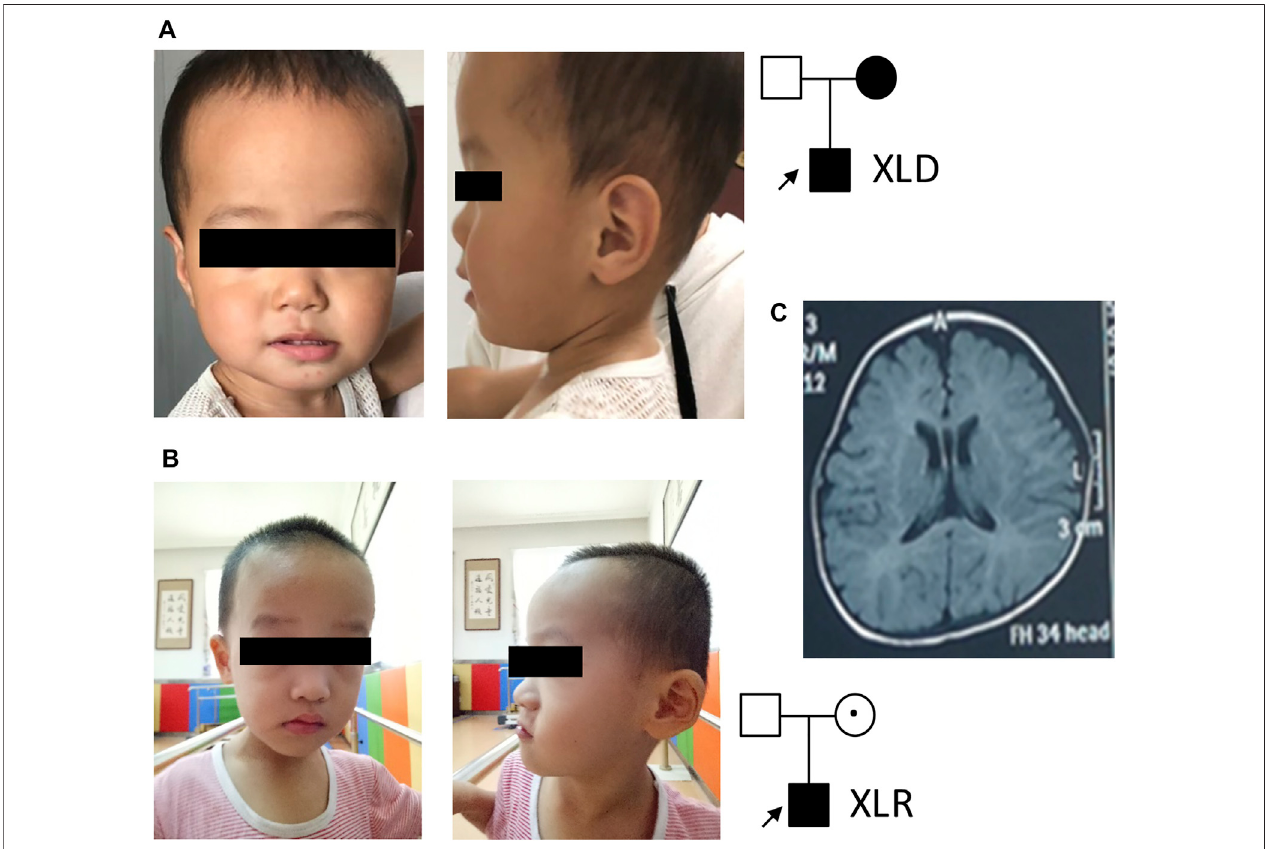
FIGURE 1 | Patient pedigrees and radiographic fi ndings. (A) Patient 1 photo and pedigree. (B) Patient 2 photo and pedigree. (C) Representative MRI image of patient 2.